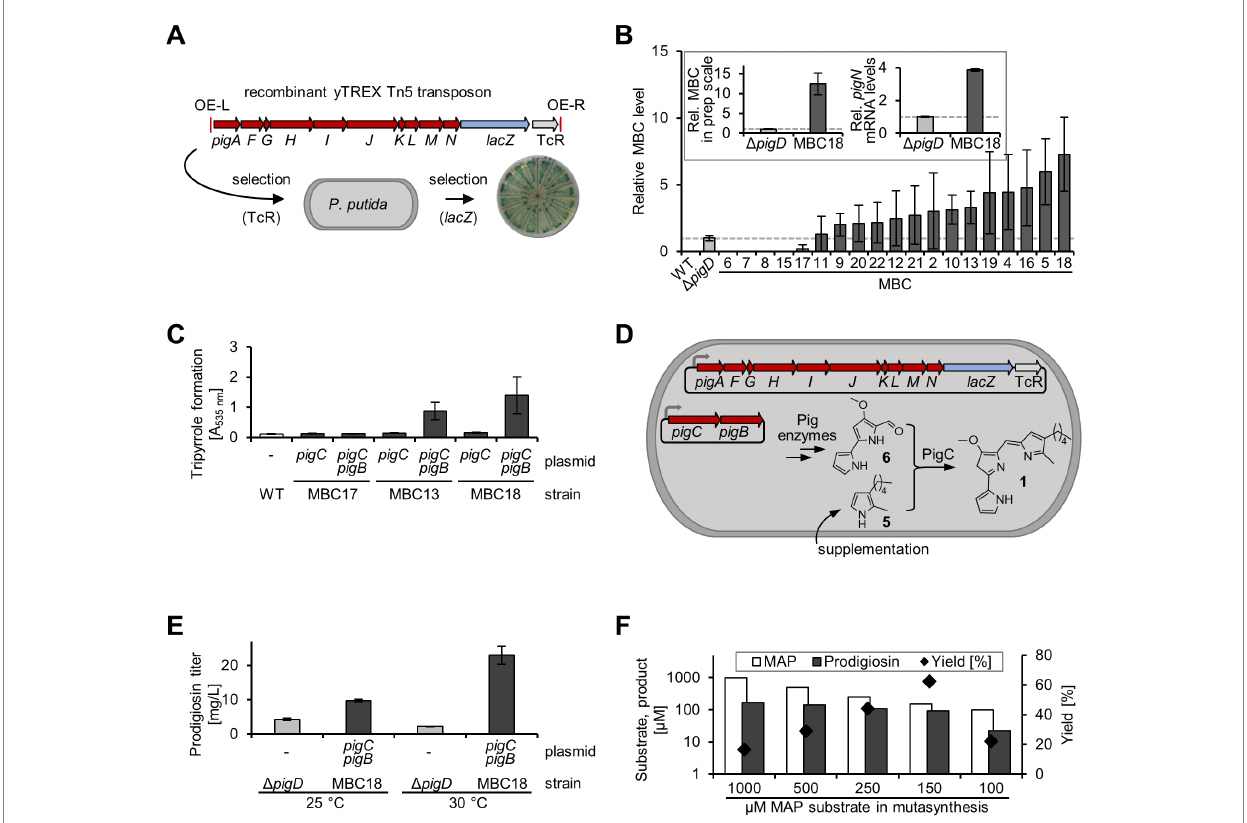
FIGURE 2 Construction of a Pseudomonas putida mutasynthesis chassis . (A) The artificial 4-methoxy-2,2 ′ -bipyrrole-5-carbaldehyde (MBC) biosynthesis- encoding gene cluster was assembled by yeast-cloning and integrated in the bacterial chromosome via Tn5 transposition. After that, expressing clones were selected based on LacZ reporter activity. (B) Relative MBC production in small scale cultivation of engineered P. putida shown as x-fold increase relative to the signal of P. putida pig-r2 Δ pigD . Left Inset: Evaluation in preparative mutasynthesis setup (100 ml scale, MBC18 with pVLT33-pigC-pigB). Right inset: Relative pigN mRNA levels. (C) Dependence of the condensation of biosynthesized MBC ( 6 ) with supplemented MAP ( 5 ) on co-expression of PigB in P. putida stains MBC17, − 13, − 18 with plasmids pVLT33-pigC or pVLT33-pigC-pigB, respectively, in small scale cultivation. (D) Genetic setup of the new mutasynthesis chassis carrying the MBC ( 6 ) biosynthetic genes in the chromosome and expressing pigC and pigB from a plasmid. (E) Mutasynthesis performance of the newly established chassis P. putida MBC18/pVLT33-pigC-pigB in comparison with hitherto used P. putida pig-r2 Δ pigD in small scale cultivation at 25 or 30 ° C. The product was detected in extracts via spectrophotometry. Shown are mean values of independently replicated measurements (min. triplicates) with the respective standard deviation. (F) Optimization of preparative mutasynthesis in 5 × 100 ml scale with P. putida MBC18/pVLT33-pigC-pigB. The amount of substrate MAP ( 5 ) was varied from 1,000 μ M to 100 μ M to optimize conditions with respect to isolated prodigiosin ( 1 ) and corresponding yields (% mol of product relative to the substance amount of